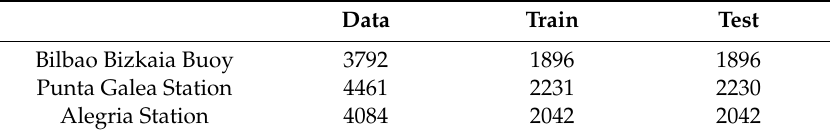
Table 1. Number of cases in each location and period.